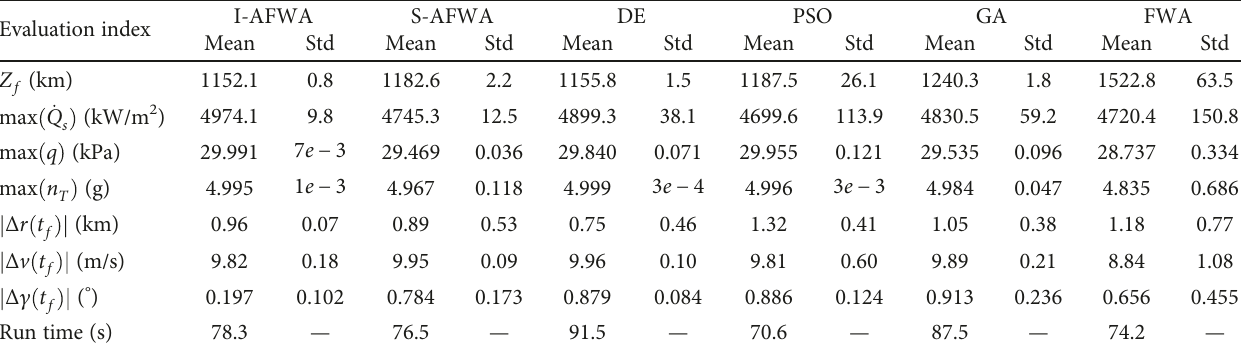
Table 2: Performance index and constraints in minimum downrange reentry trajectory optimization with the six comparative algorithms. Evaluation index